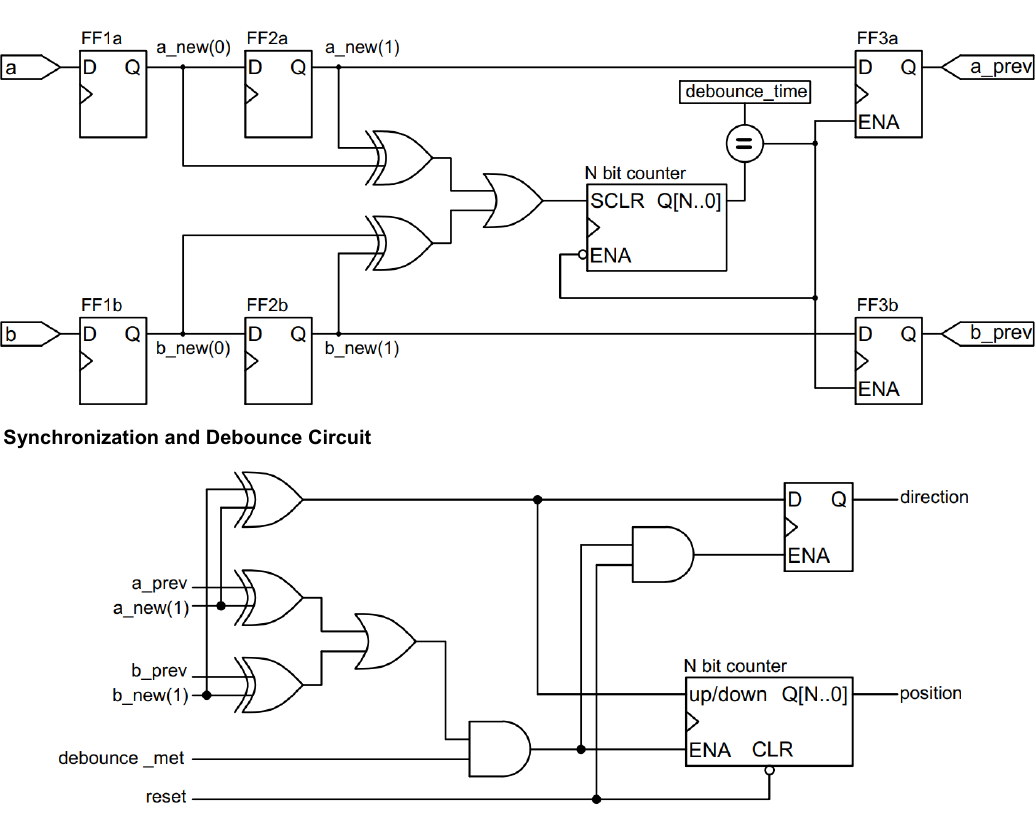
Figure 5. Decoder Circuit Table 1: Truth Table